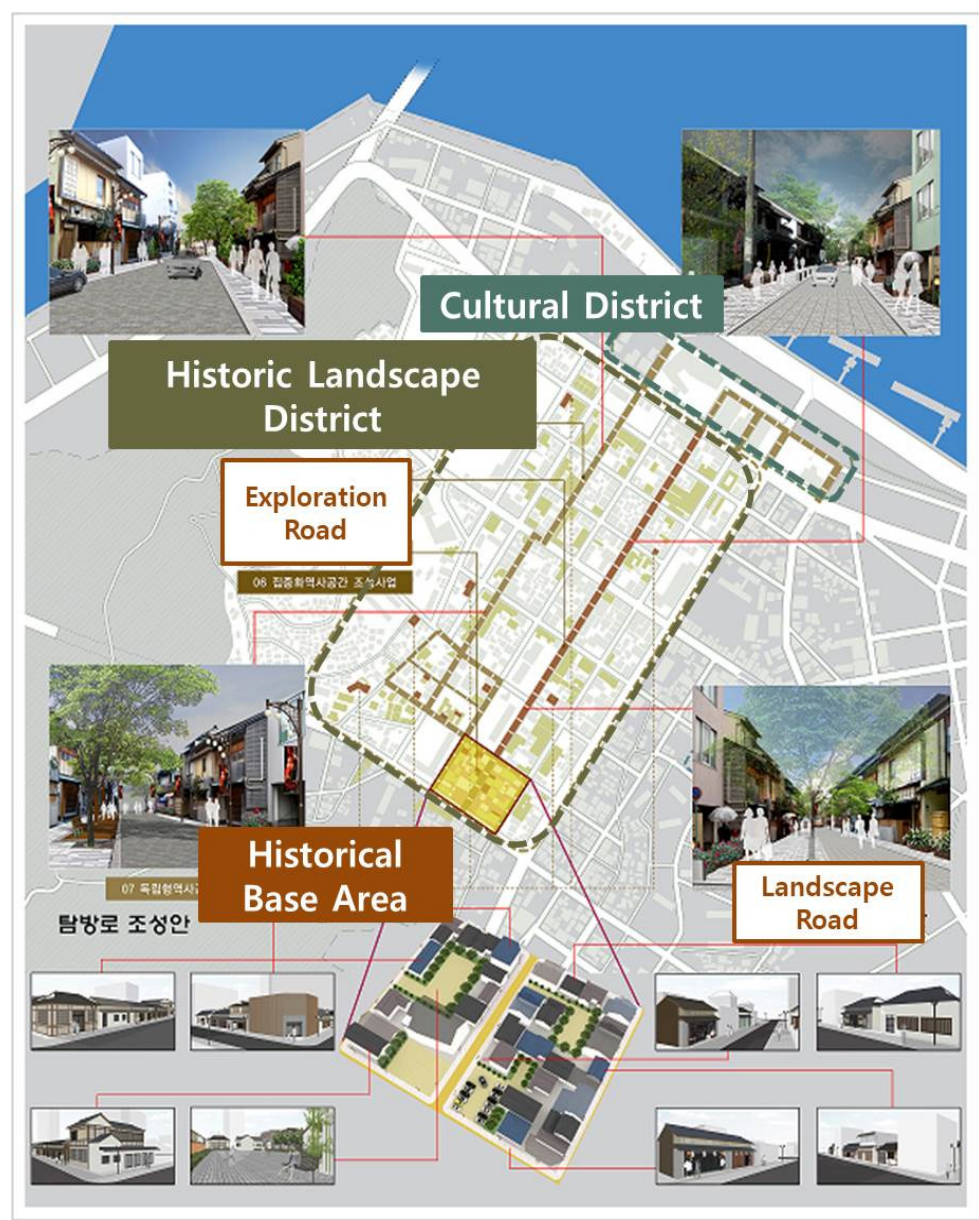
Figure 3 . Modern Cultural City Creation Project, 2009–2019 [30] . Figure 3. Modern Cultural City Creation Project, 2009–2019